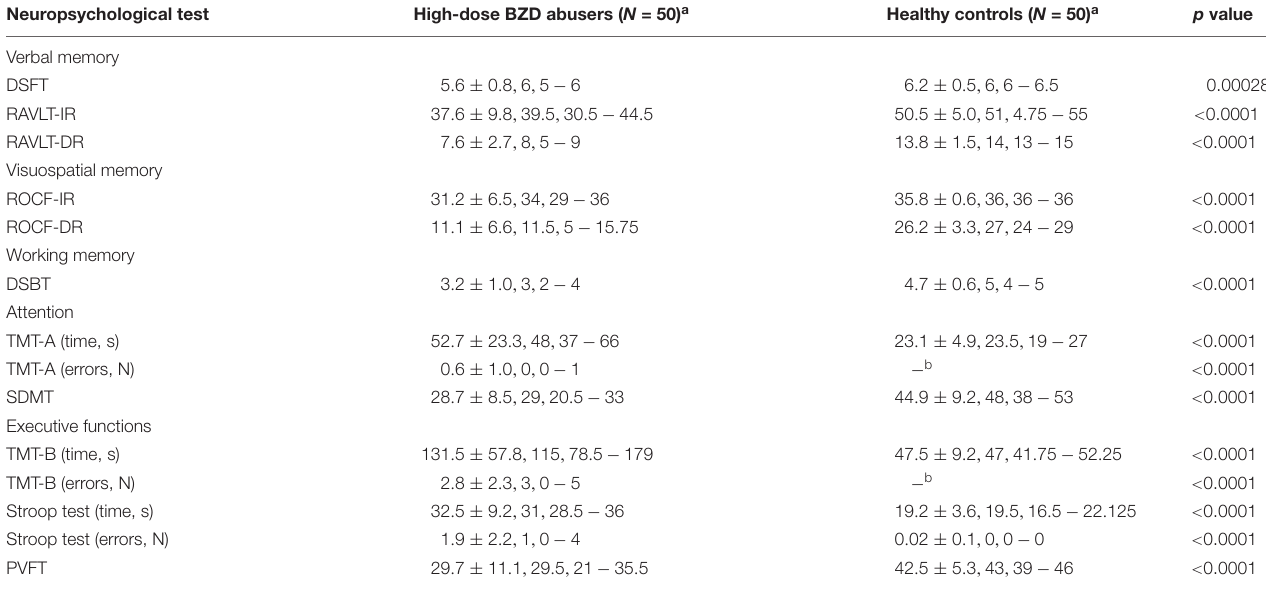
TABLE 2 | Neuropsychological measures in high-dose BZD abusers (T0) and healthy controls. Neuropsychological test High-dose BZD abusers ( N = 50) a Healthy controls ( N = 50) a